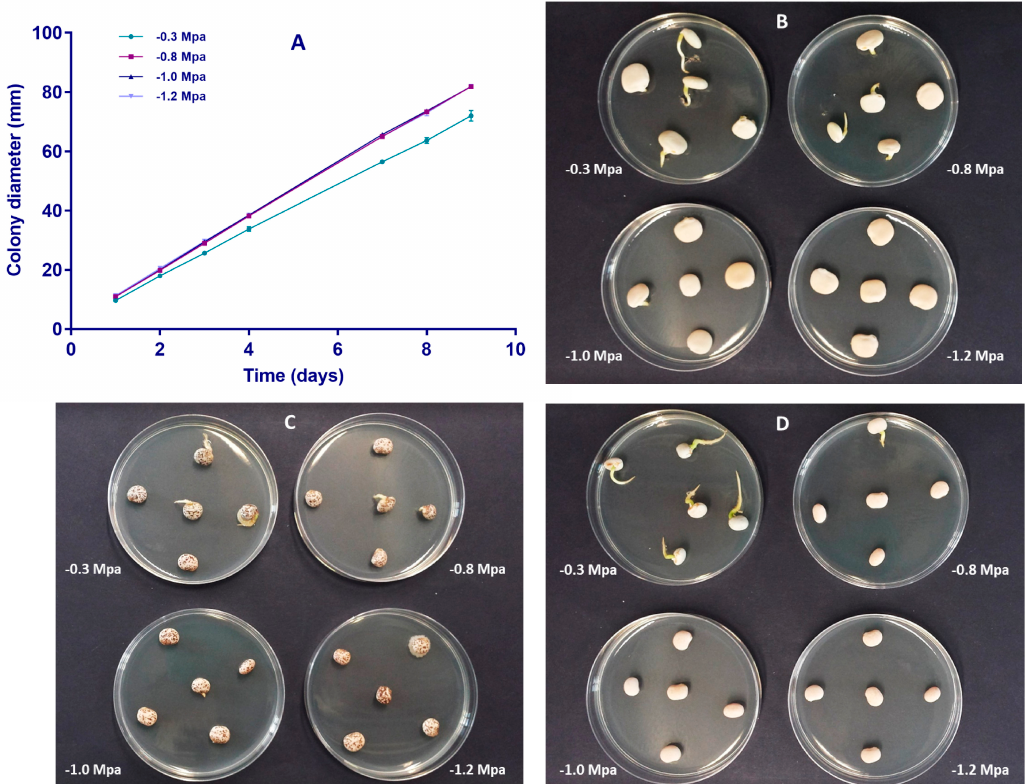
Figure 1. Mycelial growth of the isolate IMI504893 of C. lupini on Potato Dextrose Agar (PDA) osmotically modified with mannitol after 72 h of incubation ( A ). Lupin seed germination on PDA osmotically modified with mannitol: ( B ) = L. albus cv. Multitalia; ( C ) = L. luteus cv. Mister; ( D ) = L. angustifolius cv. Tango. − 0.3 Mpa = PDA alone; − 0.8 Mpa = PDA amended with 33.10 g L − 1 mannitol; − 1.0 MPa = PDA amended with 47.75 g L − 1 mannitol; and − 1.2 MPa = PDA amended with 62.46 g L − 1